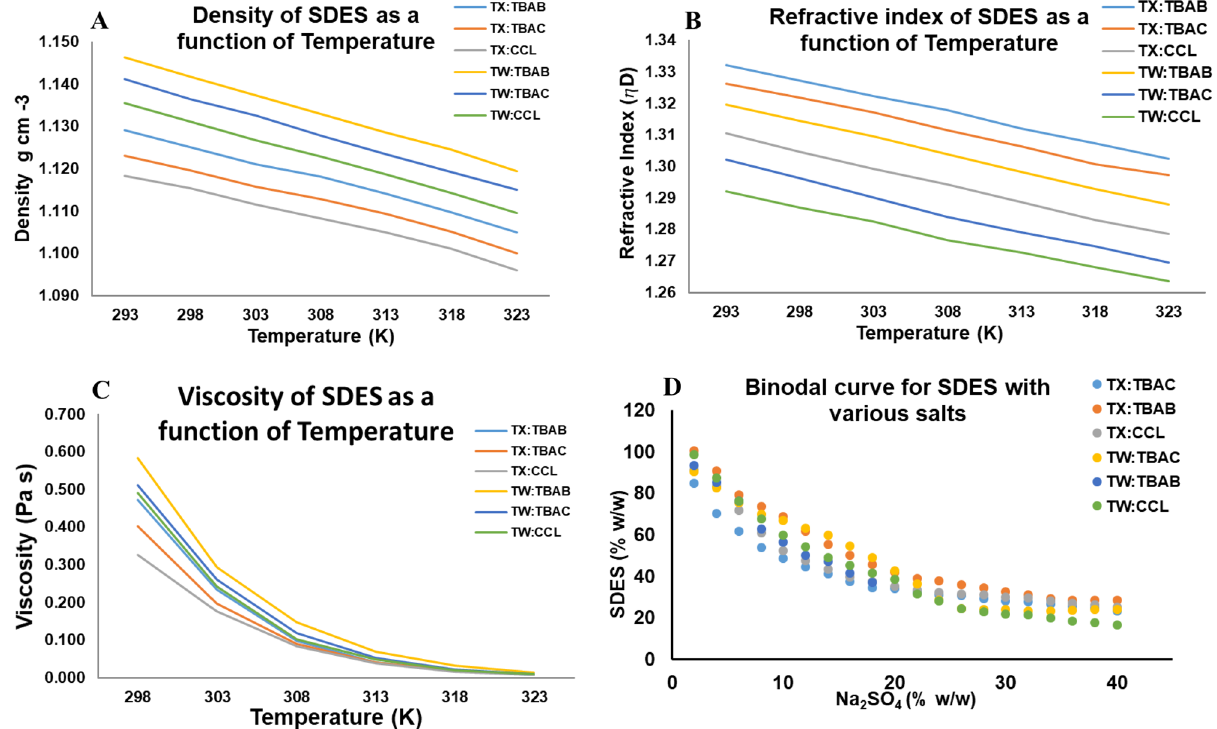
Figure 3. Density ( A ), Refractive index ( B ) and Viscosity ( C ) of different SADES subjected to temperature in the range of 293–323 K and ( D ) Binodal curve determination of various SADES with sodium